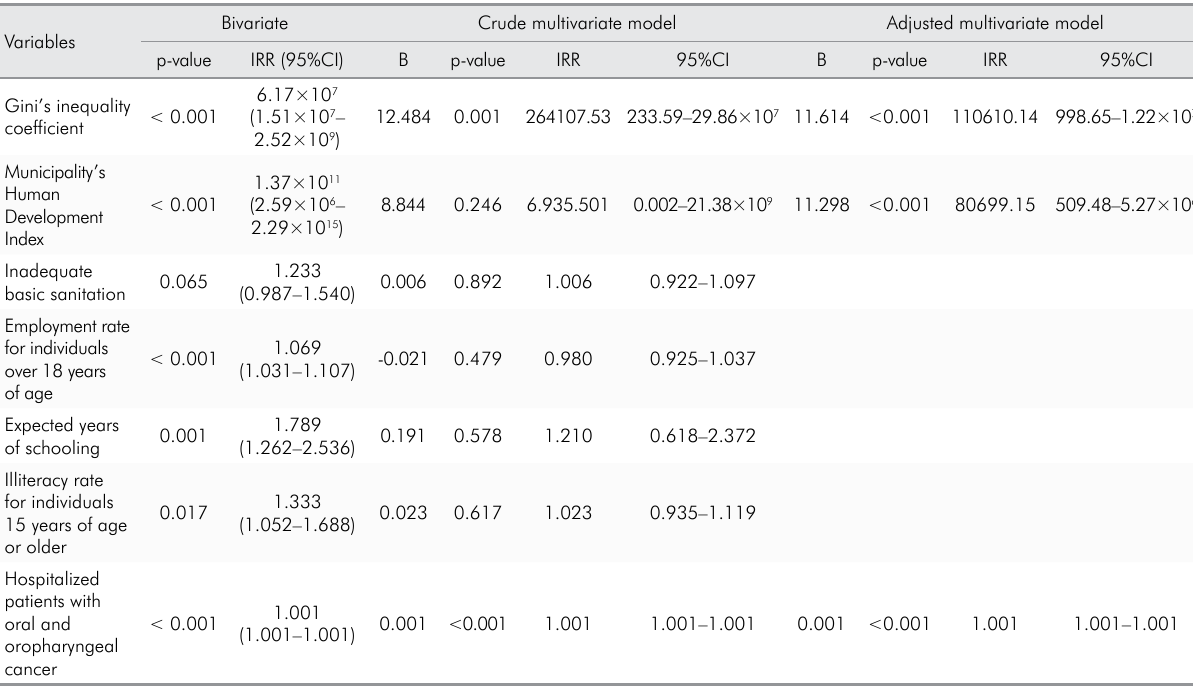
Table 3. Bivariate and multivariate Poisson regressions to determine the effect of independent variables (socioeconomic factors) on the frequency of oral mucosal changes, as based on the records of primary care services of the Brazilian public healthcare system.